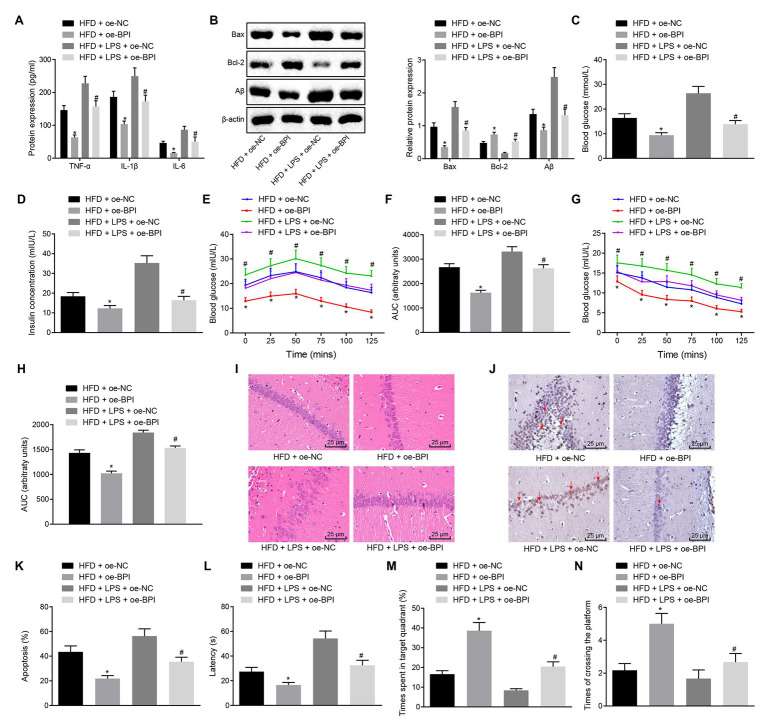
Inflammation, insulin resistance, and cognitive impairment are inhibited following BPI upregulation in diabetic mice. (A) Serum levels of inflammatory factors of mice in each group detected by ELISA. (B) Western blot analysis of Bax, Aβ, and Bcl-2 proteins in hippocampal tissues of mice in each group. (C) Determination of fasting blood glucose levels of mice in each group. (D) Quantitation of fasting insulin amount of mice in each group. (E) Blood glucose levels of mice in each group using the glucose tolerance test. (F) The AUC corresponding to E. (G) Blood glucose levels of mice in each group using the insulin resistance test. (H) The AUC corresponding to the G. (I) HE staining of the hippocampal tissues of mice in each group (400×). (J) Cell apoptosis in the hippocampal tissues of mice in each group detected using TUNEL staining (400×). (K) The statistical analysis chart corresponding to J. (L) The latency of mice in each group determined by Morris water maze. (M) The ratio of time that mice in each group staying in the quadrant of the platform. (N) The number of mice in each group passing the target platform quadrant. *p < 0.05 vs. the HFD mice injected with oe-NC. #p < 0.05 vs. the HFD mice injected with LPS and oe-NC. The results were measurement data and expressed as mean ± standard deviation. Data between two groups were compared by independent sample t-test.